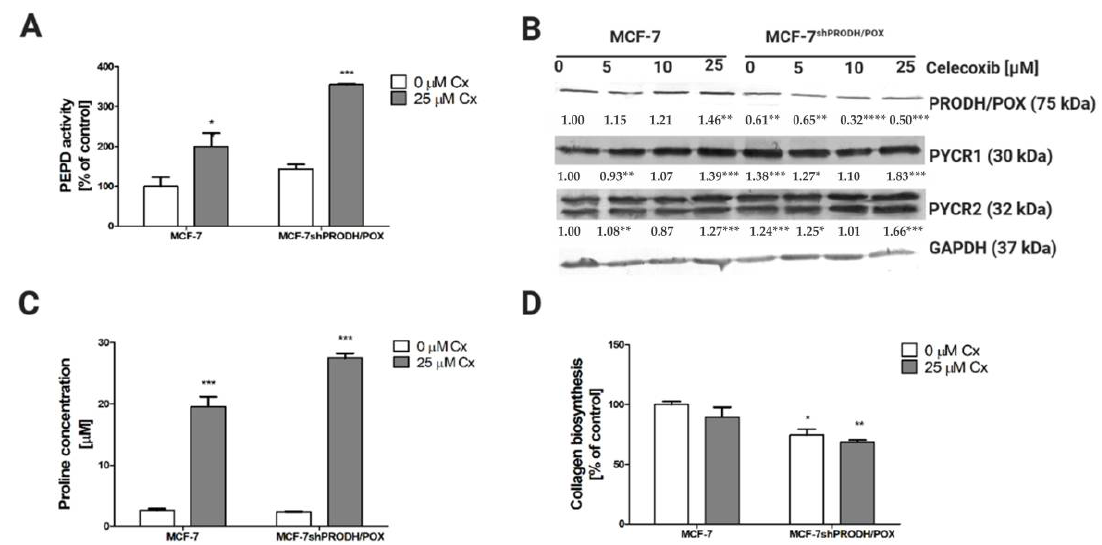
Figure 3. Celecoxibaffects proline metabolism in breast cancer cells: ( A ) prolidase activity after treatment with Cx for 24 h in MCF-7 and MCF-7 shPRODH/POX cells; ( B )Western blot analysis of proteins related to proline cycle; representative blot images were shown (the mean value of densitometric analysis of protein bands presented below each blot; * p < 0.05, ** p < 0.01, and *** p < 0.001, **** p < 0.0001). Supplementary Materials contain statistical analysis of the evaluated proteins; ( C ) LC–MS analysis of proline in Cx-treated MCF-7 and MCF-7 shPRODH/POX cells after 24 h treatment; ( D ) collagen biosynthesis after treatment with Cx for 24 h. * p < 0.05, ** p < 0.01, and *** p <